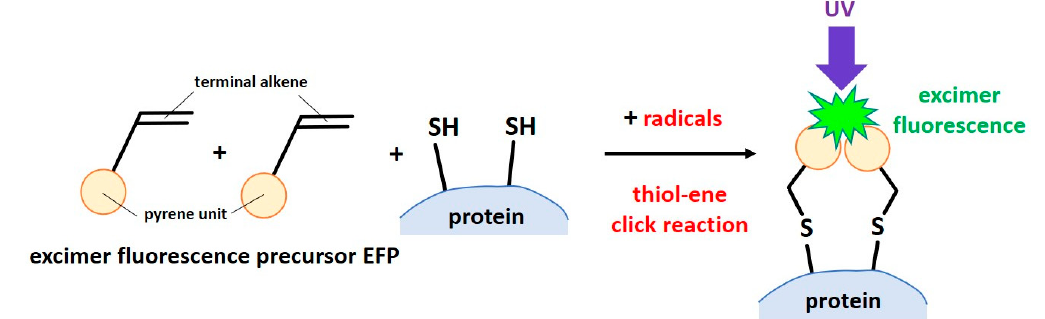
Figure 1. Schematic illustration of thiol-ene click reactions between the excimer fluorescence precursor ( EFP ) and SH groups of a protein. The EFP labeling of the neighboring SH groups produces the complex which exhibits pyrene excimer fluorescence.